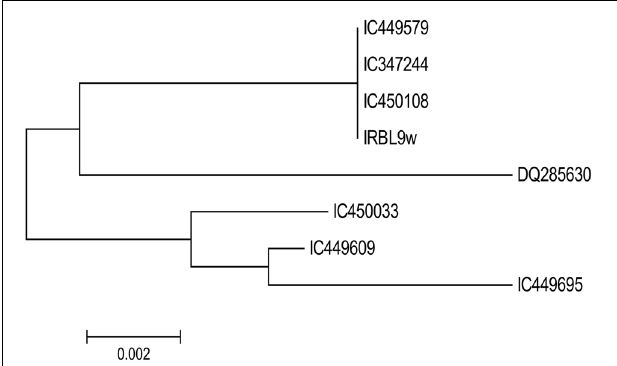
FIGURE 3 | Phylogenetic tree of Pi9 allele based on nucleotide sequences of seven rice landraces along with one reference sequence.